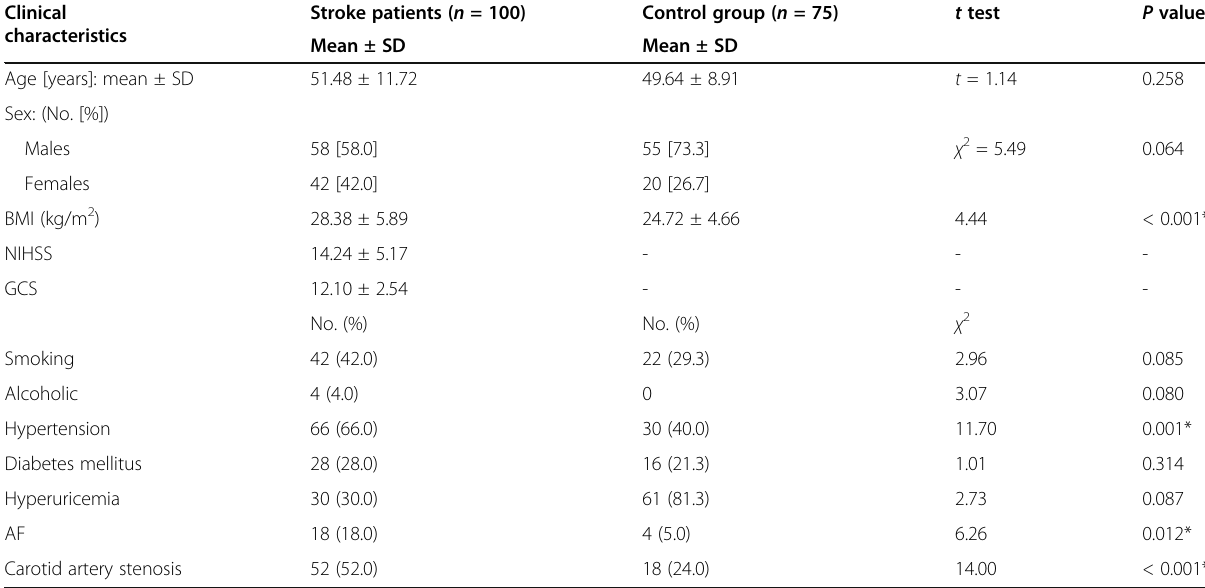
Table 1 Clinical characteristics of cerebrovascular stroke patients and control group Clinical characteristics